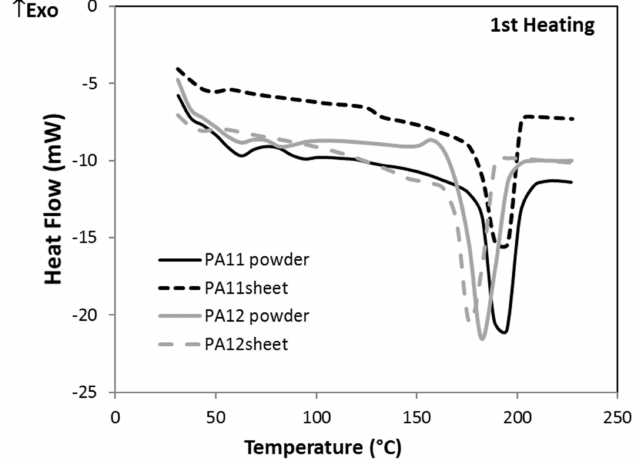
Figure 12. DSC thermograms of PA powders and sheets in the first heating